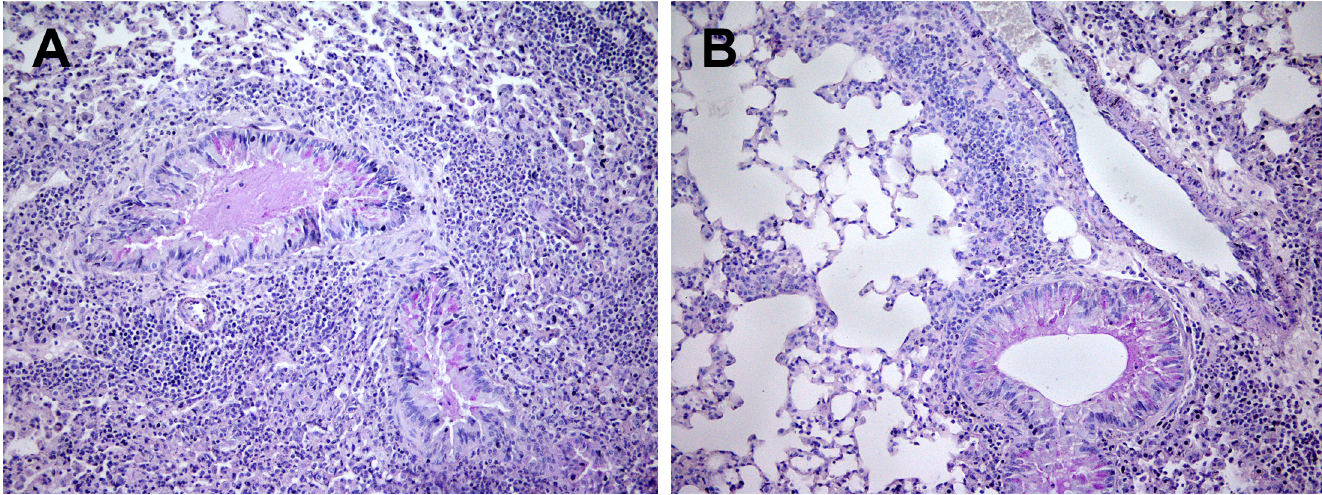
Fig 3. Increased inflammation in the lungs of NCR1 gfp/gfp mice (H&E+PAS x270). Mice were immunized and samples were process as described in Fig 2. (A) OVA immunized NCR gfp/gfp (H&E+PAS x270). (B) Alum immunized NCR gfp/gfp (H&E+PAS x270).